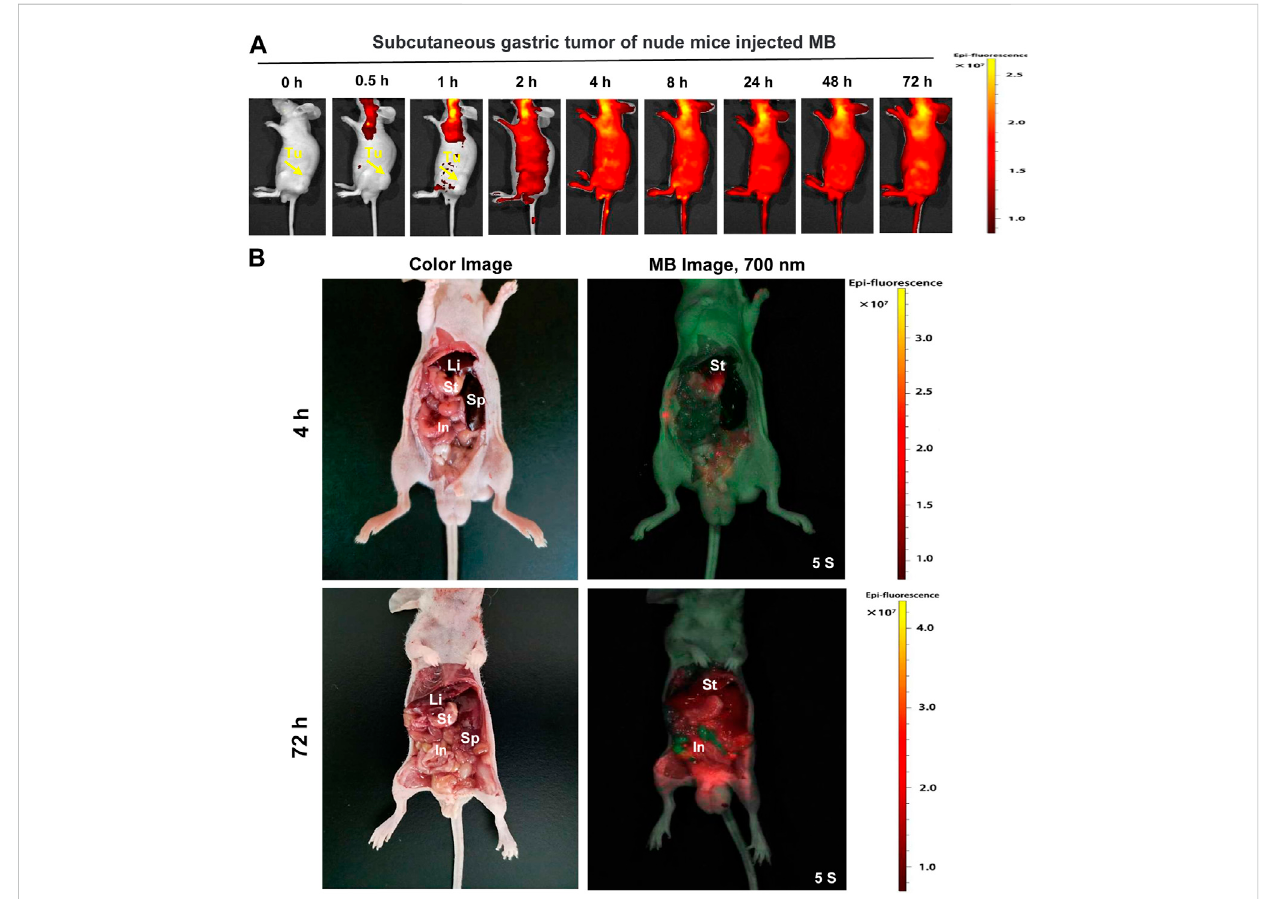
FIGURE 5 Real-time NIR targeted imaging after the injection of NIR fl uorophores MB in the subcutaneous gastric tumor of nude mice. MB was injected intravenouslyintogastricsubcutaneoustumor-bearingnudemice,andtheNIR fl uorescencesignalswereobservedat0.5,1,2,4,8,24,48,and72 hpost- injection under the NIR imaging system. (A) Real-time NIR fl uorescence imaging of gastric subcutaneous tumor-bearing nude mice at different time points. (B) NIR imaging of the abdominal cavity of nude mice at 4 h and 72 h post-injection MB. Yellow arrows indicate tumor grafts in the left fl